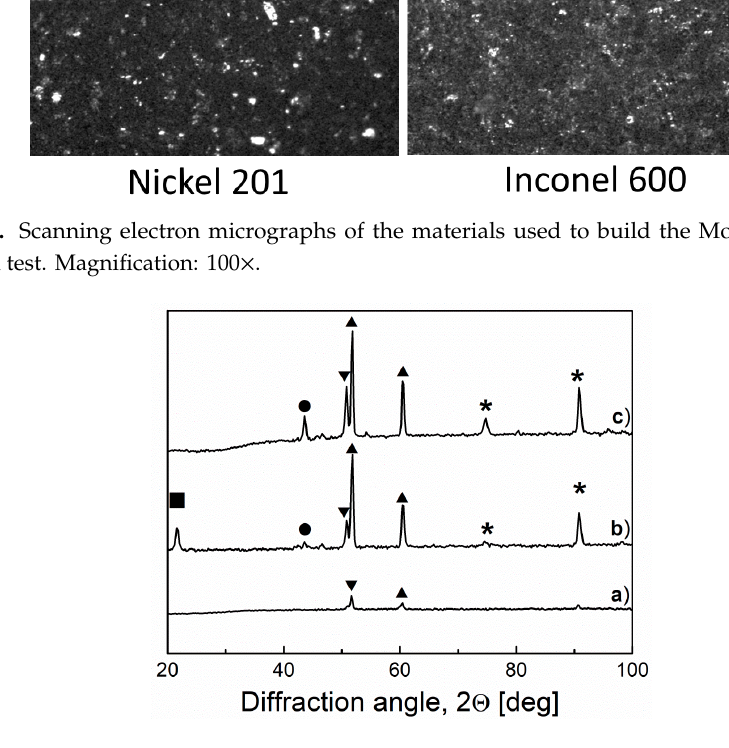
Figure 23. XRD pattern recorded for the raw Inconel 600 ( a ), Inconel 600 after lithiation process ( b ) and Inconel 600 after 43 h of cell work ( c ). ( (cid:4) ) Li 0.4 Ni 0.6 O, ( • ) Li 0.05 Ni 0.95 O, ( (cid:78) ) Ni, ( (cid:72) ) NiO, ( (cid:107) ) Li 0.1 Ni 0.9 O.